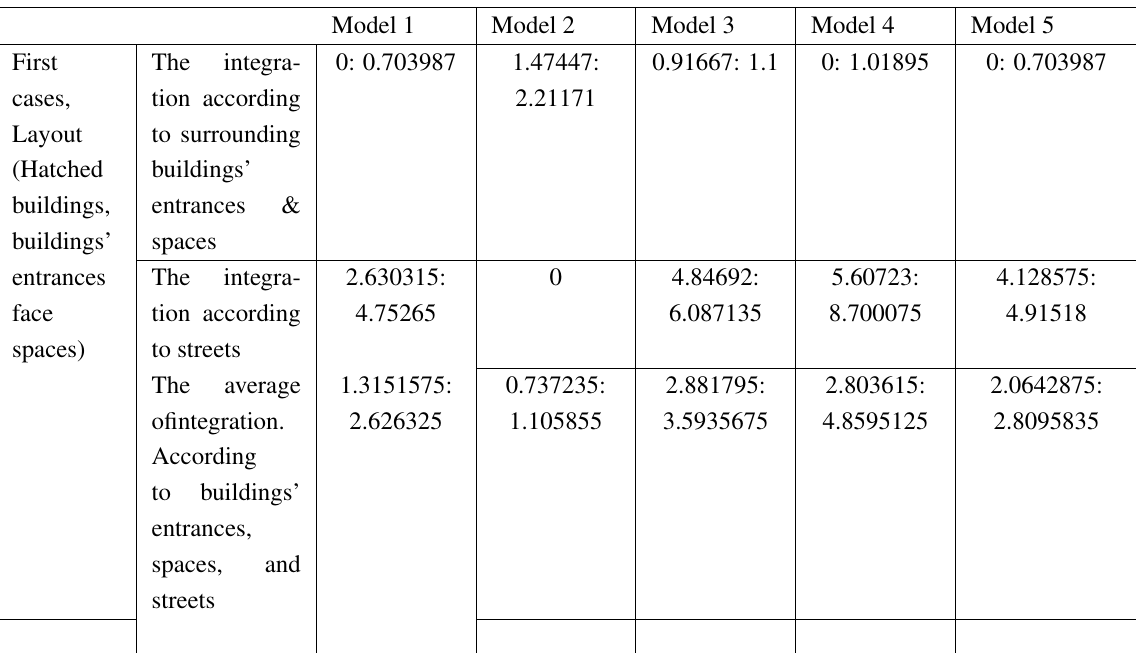
Table 3. The results of models’